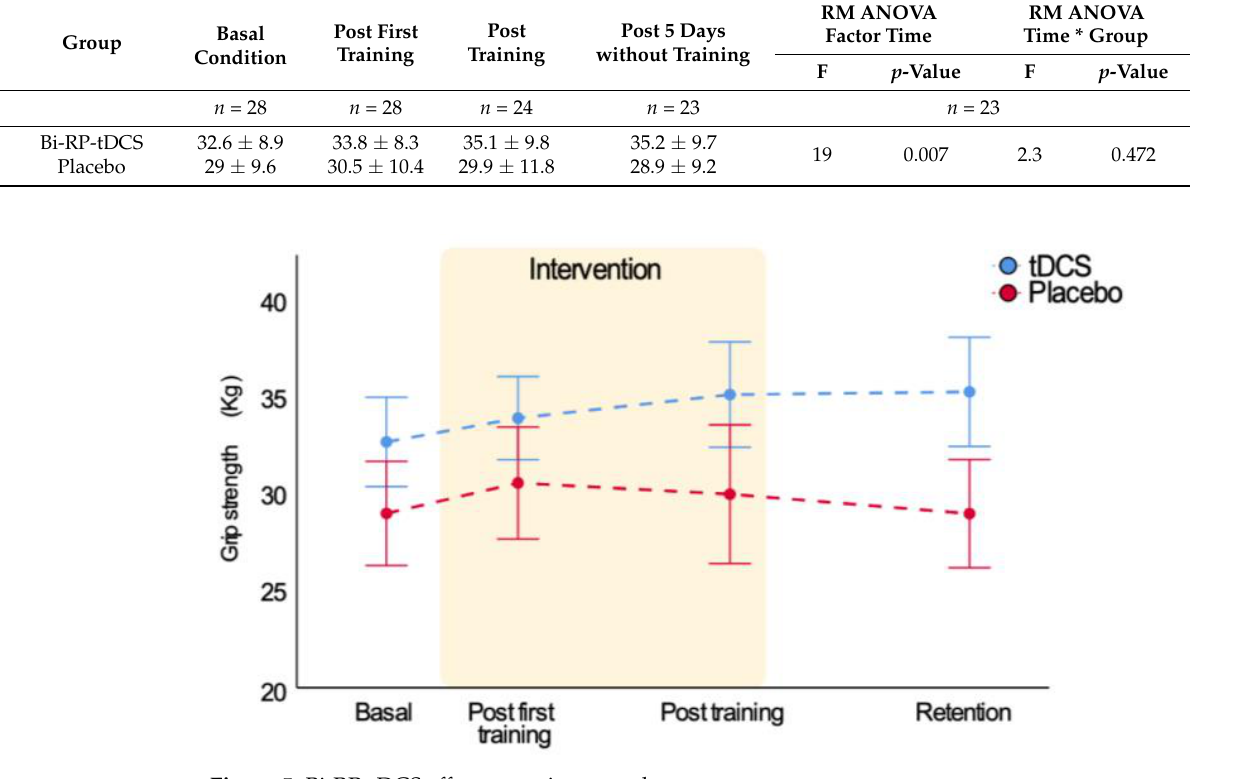
Table 4. Training and bi-RP-tDCS effects on sensory variables (mean ±